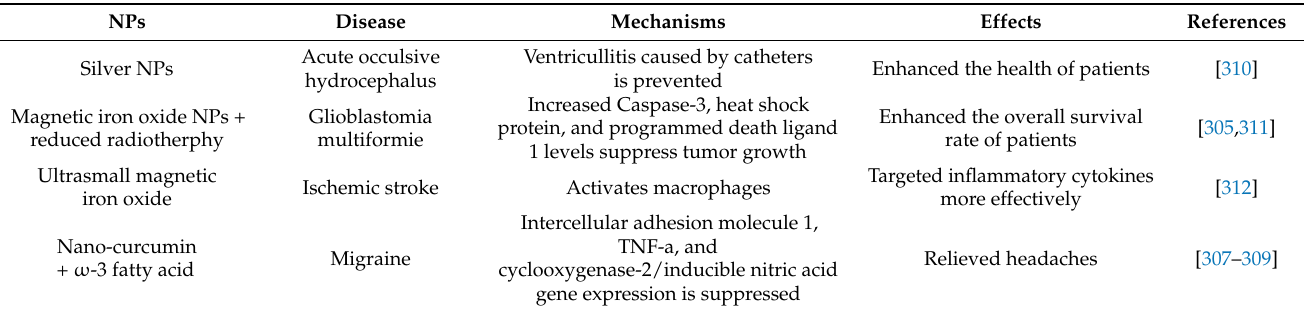
Table 2. Treatment trials using NPs for brain diseases and